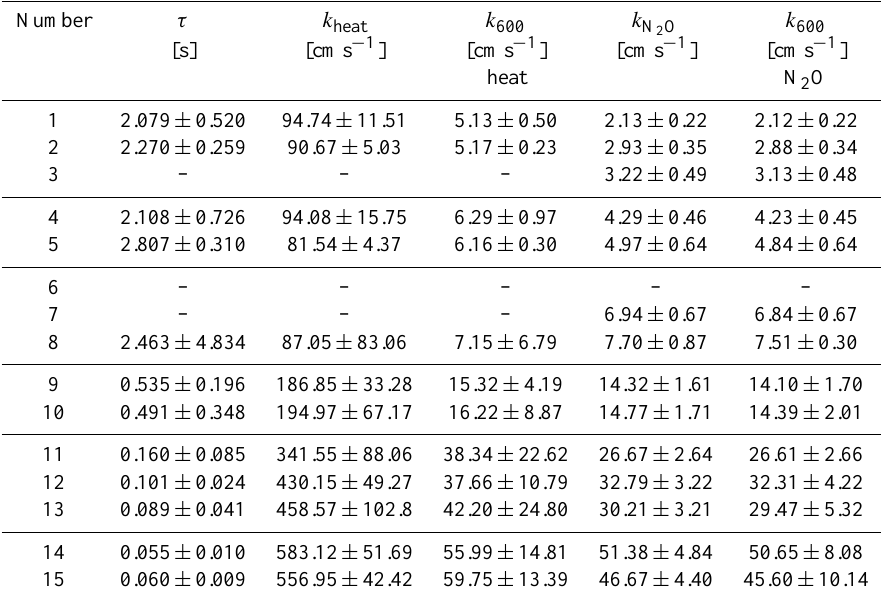
Table A2. Measured response times τ , heat transfer velocities k heat , transfer velocities of N 2 O ( k N and k N 2 O